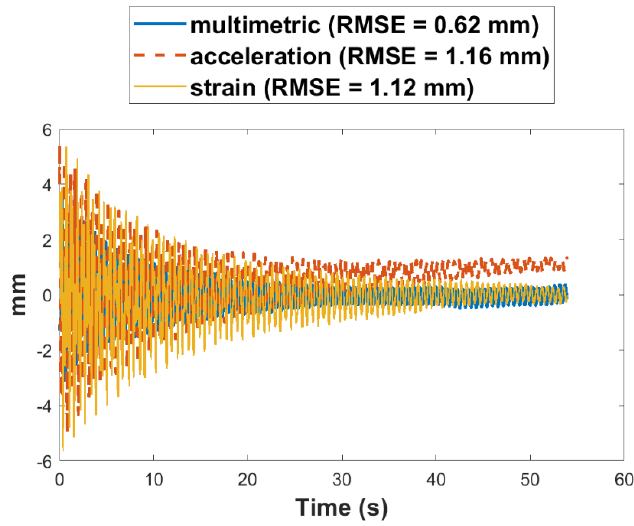
Figure 11. First-story displacement errors from different methods.